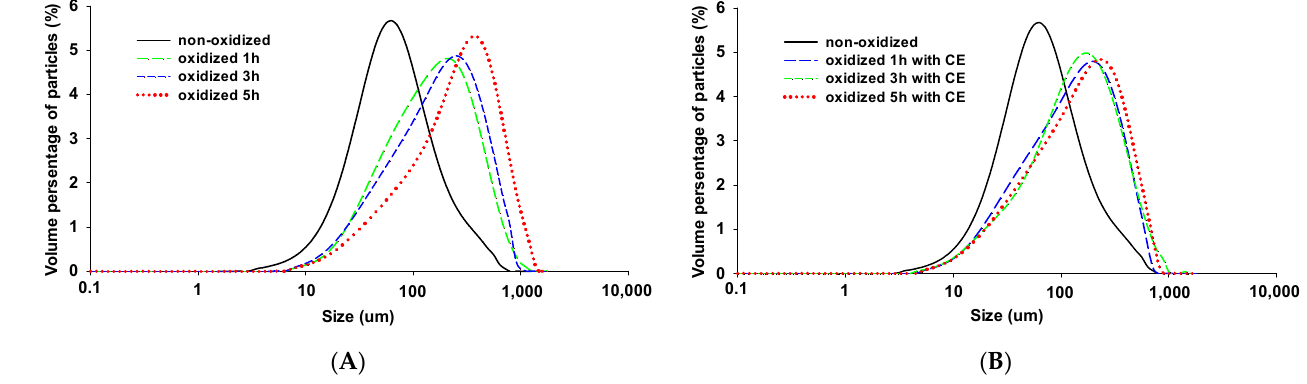
Figure 4. Particle size distribution of MPs at different oxidation times (0, 1, 3, and 5 h) ( A ) and CE under different oxidation times ( B ).